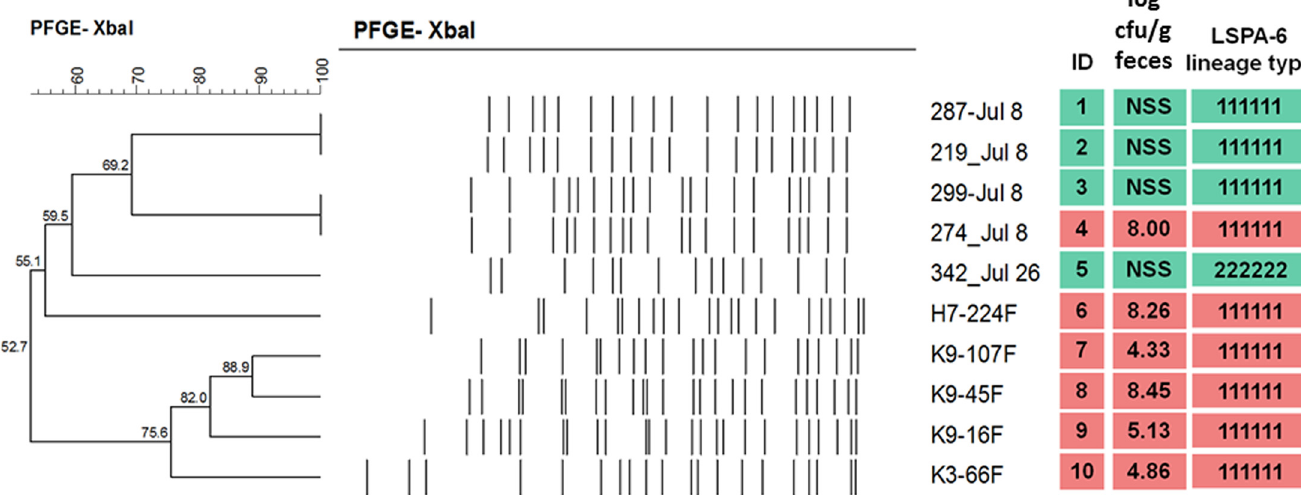
PLOS ONE | DOI:10.1371/journal.pone.0151673 March 28,